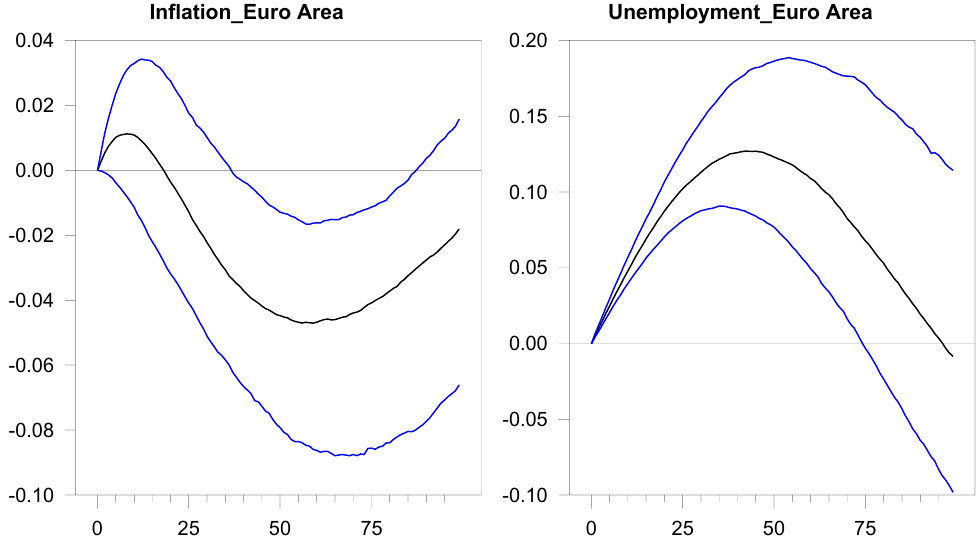
Figure 3. Responses of Euro Area inflation and unemployment to a contractionary monetary policy shock. Monetary policy shock identified as exogenous innovation to the differential between the European Overnight Average Interest Rate (EONIA) and the Federal Funds Rate. Error bands set at the 10th and the 90th percentiles.